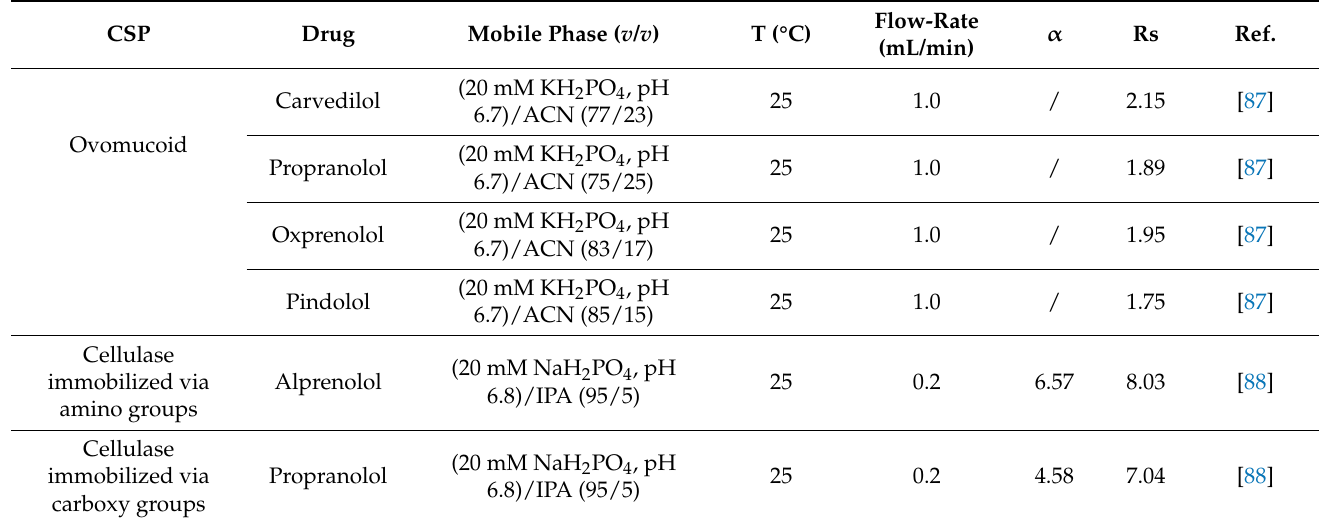
Table 9. Typical results for the enantioseparation of β -blockers on Protein-based